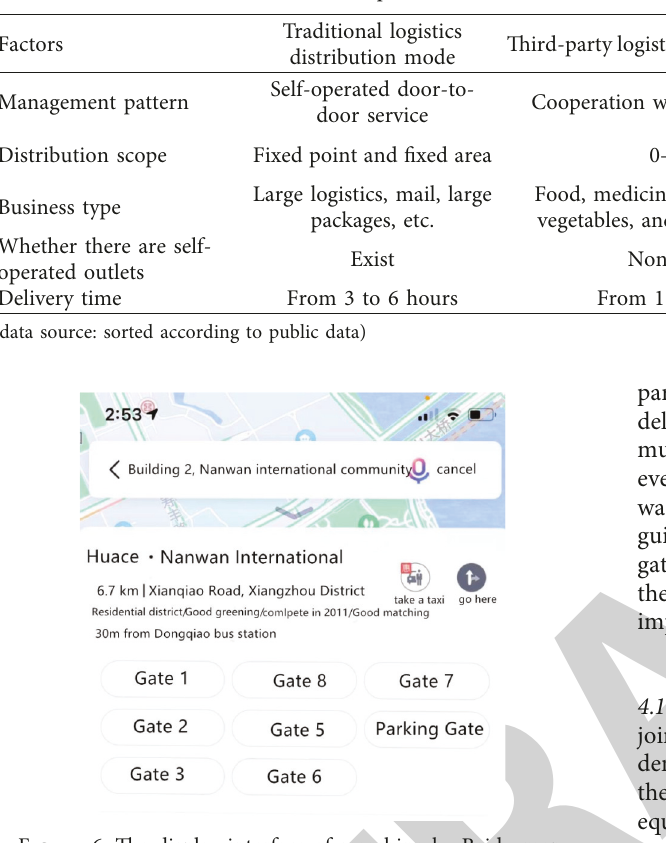
Table 3: Comparison of distribution conditions of different distribution modes.